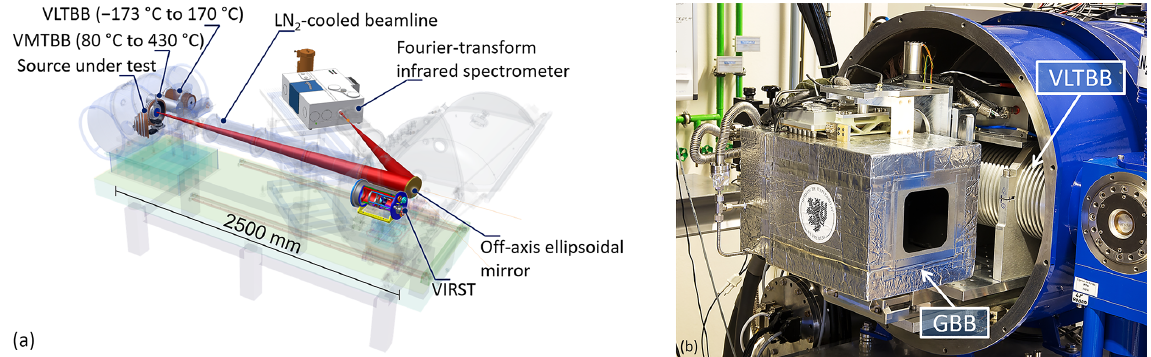
Figure 5. (a) The Reduced Background Calibration Facility (RBCF) at PTB and (b) the large-area balloon blackbody inside the source chamber of the RBCF.